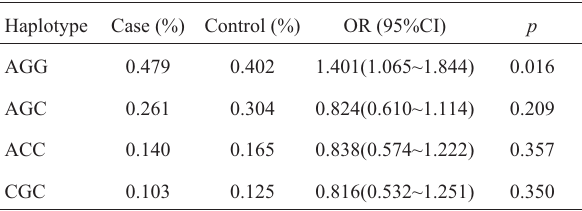
Table 6 - XPD haplotype frequencies and associations with pancreatic cancer risk in the Chinese Han population. Haplotype Case (%) Control (%) OR (95%CI)